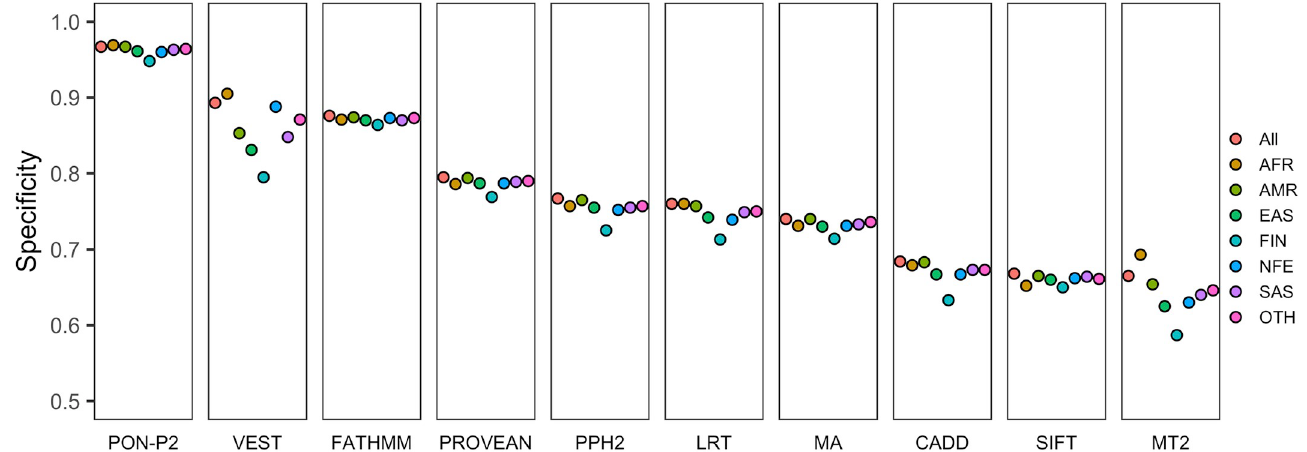
Fig 2. Performance of variant tolerance predictors for variants in ethnic groups. Specificities of prediction tools for common variants (AF � 1% and < 25%) in different populations. AFR, African; AMR, American; EAS, East Asian; FIN, Finnish; NFE, Non-Finnish European; OTH, Other; SAS, South Asian; MA, MutationAssessor; MT2, MutationTaster2; PPH2,